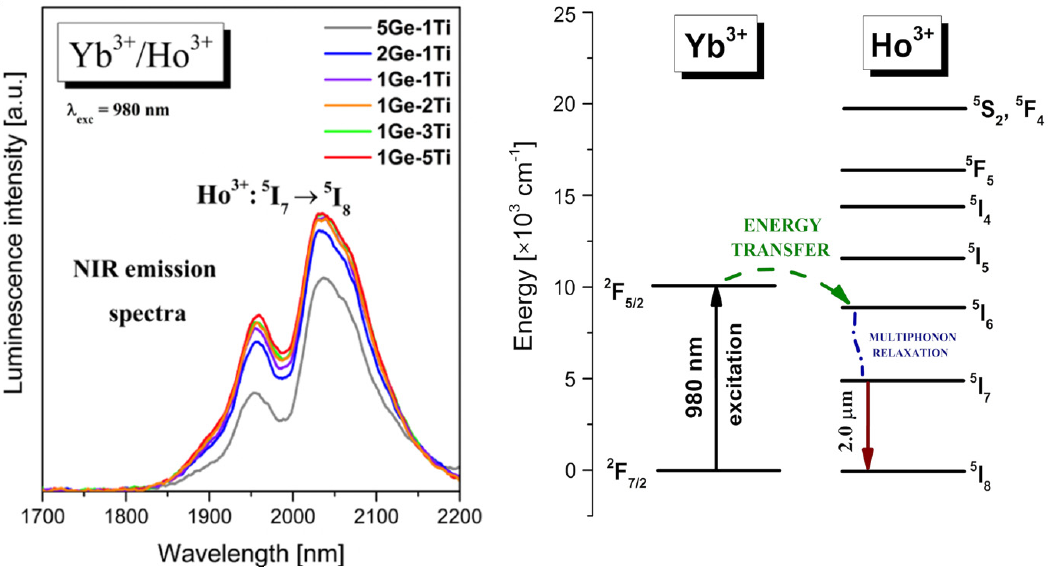
Figure 5. Near-infrared emission spectra and energy level diagram for titanate–germanate glasses co-doped with Yb 3+ /Ho 3+ .